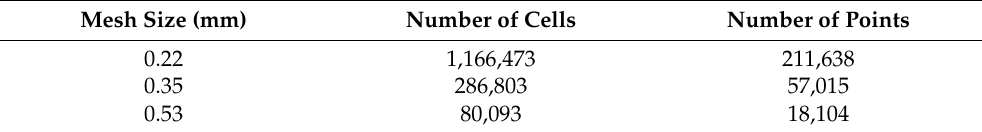
Table 10. Mesh information for CHN13 model